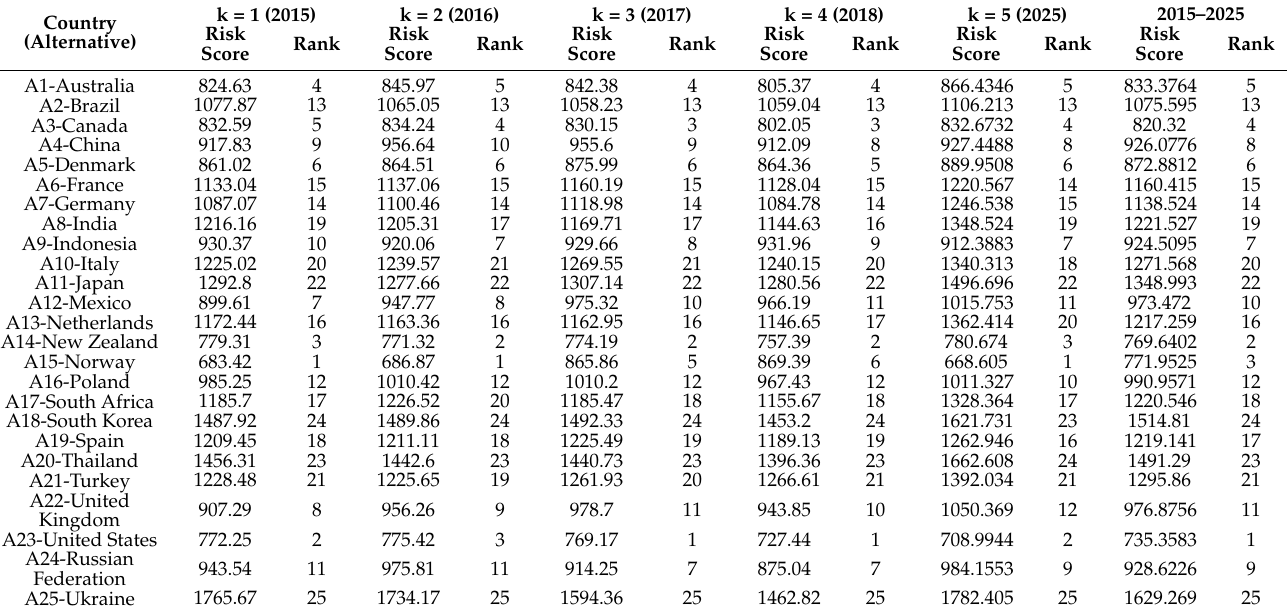
Table 4. The results of the energy security assessment in subsequent periods of time and the aggregate assessment of all periods based on the SAW